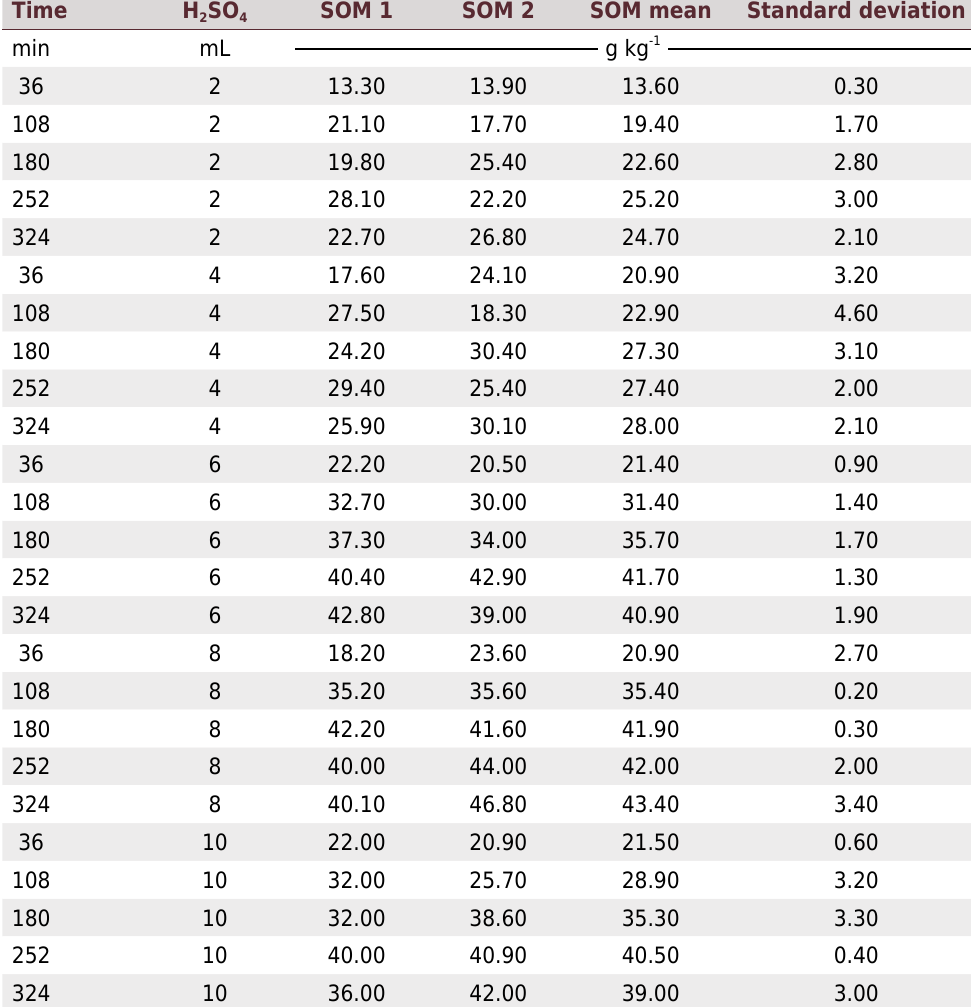
Table 4. Soil organic matter (SOM) content in the sample of soil with biochar by Mebius method as a result of the factorial design